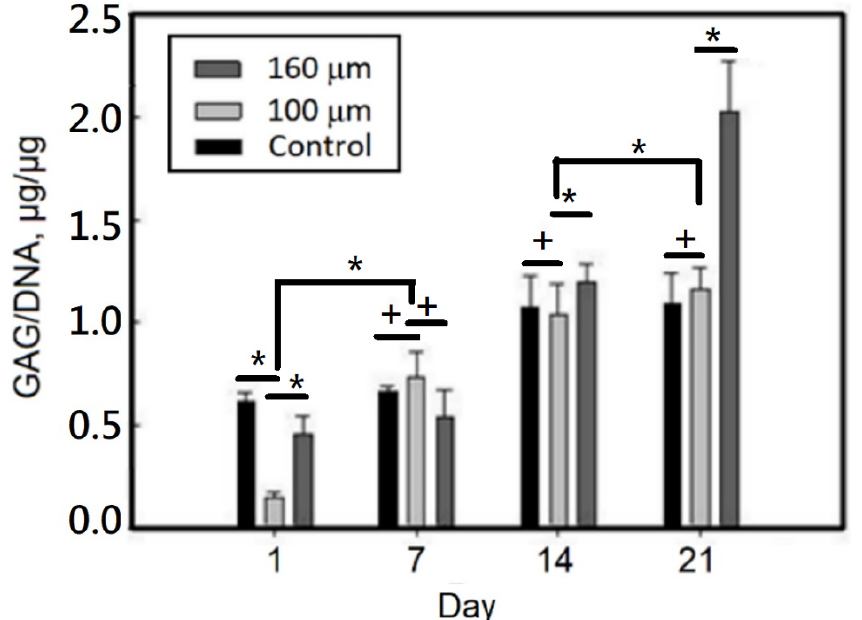
Figure 8. GAG/DNA of static culturing chondrocytes on gelatin-based hydrogel scaffolds. Values with different superscripts were significantly different ( p < 0.05); *, statistical significance between the groups ( p < 0.05); +, nonsignificance within the group ( p > 0.05); n = 6.